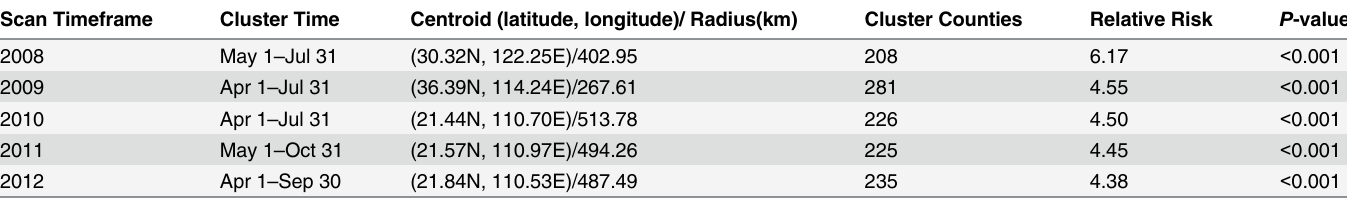
Table 2. The most likely space-time clusters of HFMD in mainland China, 2008 –